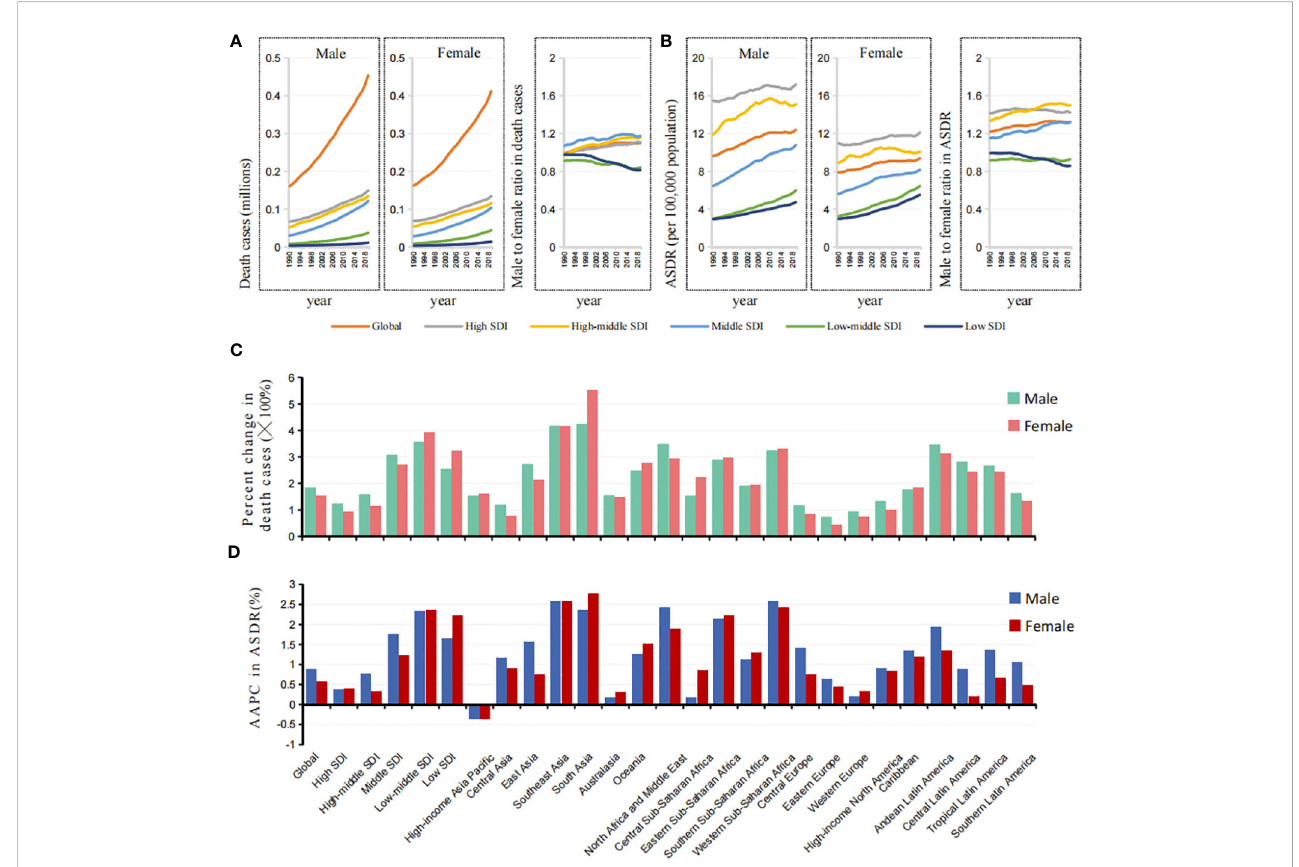
FIGURE 3 Sex differences and trends of ASDR in cancers attributable to metabolic factors by different SDIs and GBD regions. (A) The death cases in cancers attributable to metabolic factors in males and females, and male to female ratios by SDIs from 1990 to 2019. (B) The ASDRs in cancers attributable to metabolic factors in males and females, and male to female ratios by SDIs from 1990 to 2019. (C) The changes of death cases in cancers attributable to metabolic factors in males and females by SDIs and GBD regions from 1990 to 2019. (D) The AAPCs of ASDR in cancers attributable to metabolic factors in males and females by SDIs and GBD regions from 1990 to